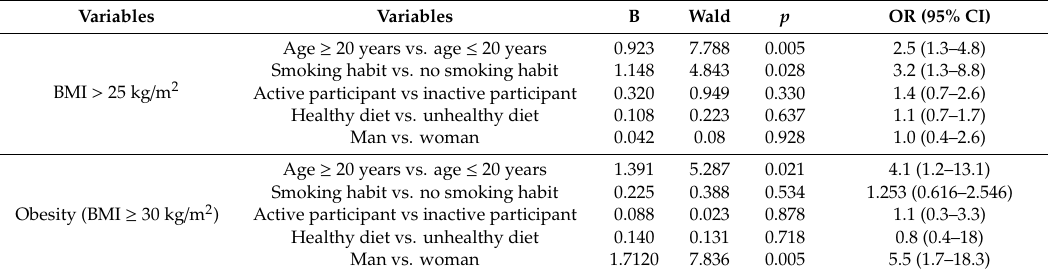
Table 4. Variables that were found by logistic regression to be associated with the presence of a high